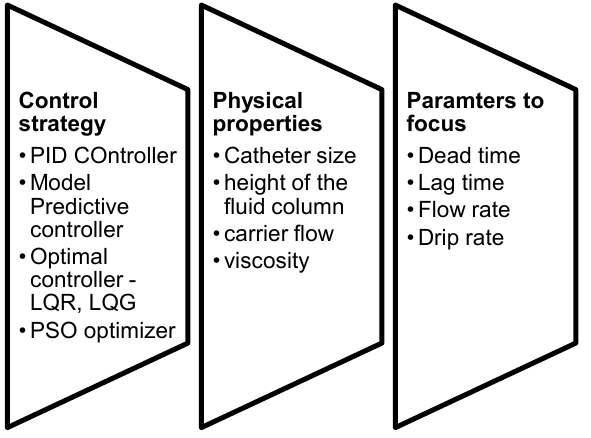
Figure 2. Control strategy and parameters need in infusion